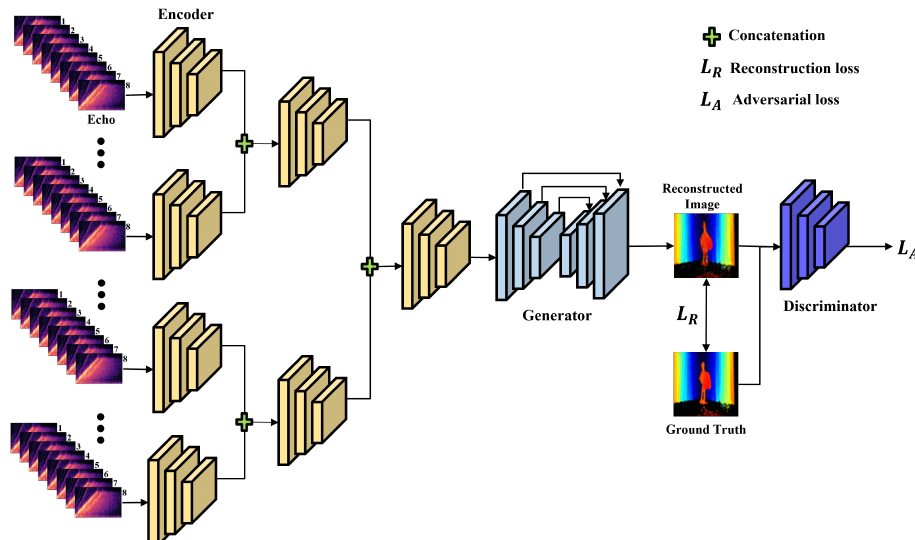
Figure 5. The model generates the depth map from the echoes. The encoder hierarchically extracts hidden object features from the echoes. Then extracted features are concatenated and then reshaped. The generator used the features extracted from the echoes to create a depth map. The discriminator compares the generated depth map with the